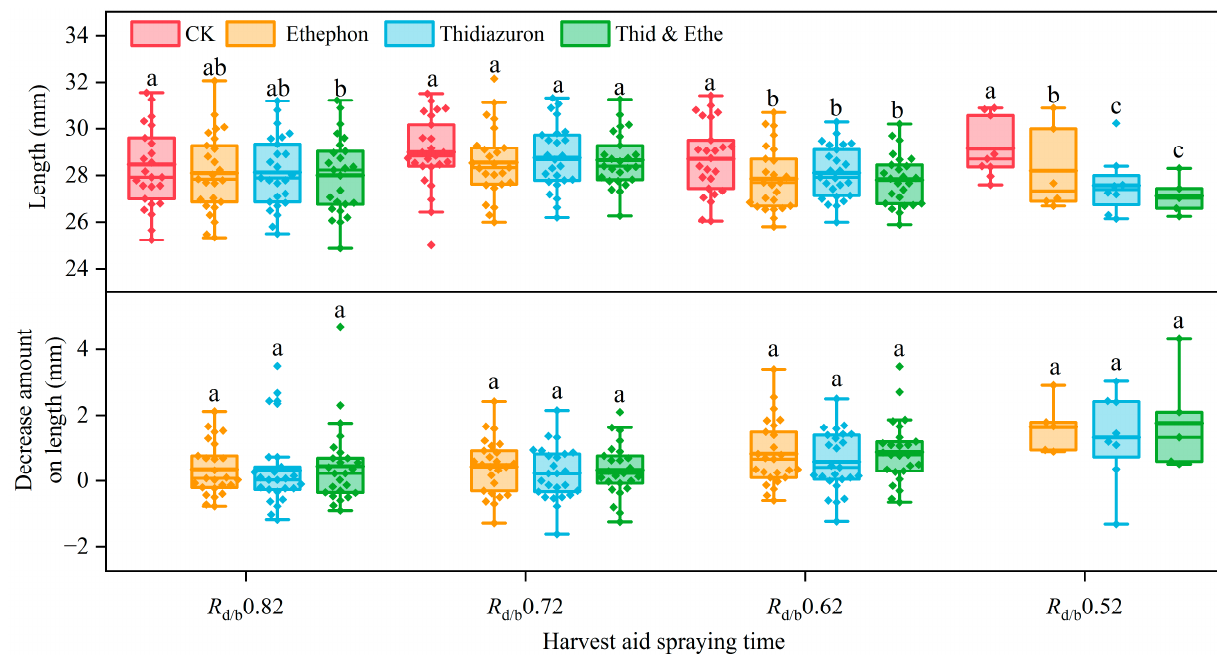
Figure 6. Effects of harvest aid spraying time on fiber length. The thick solid line in the figure indi-